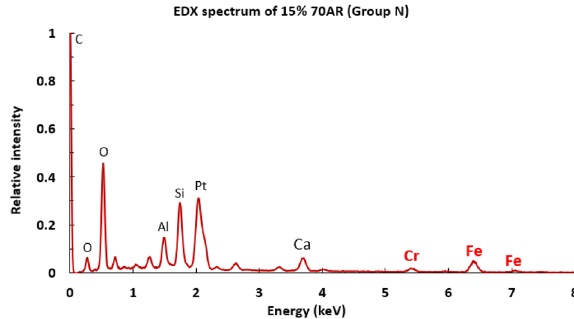
Figure 11. EDX analysis of Group I